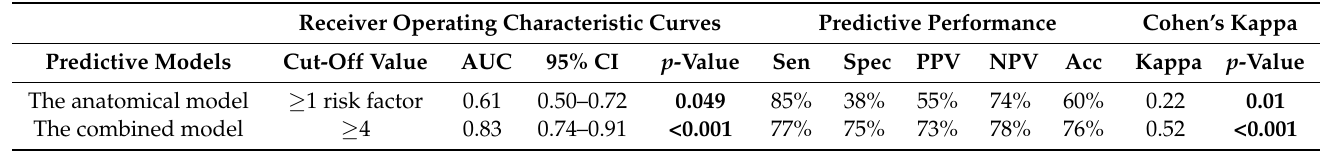
Table 6. Predictive performance of the anatomical model and the combined model of severe OSA of Study